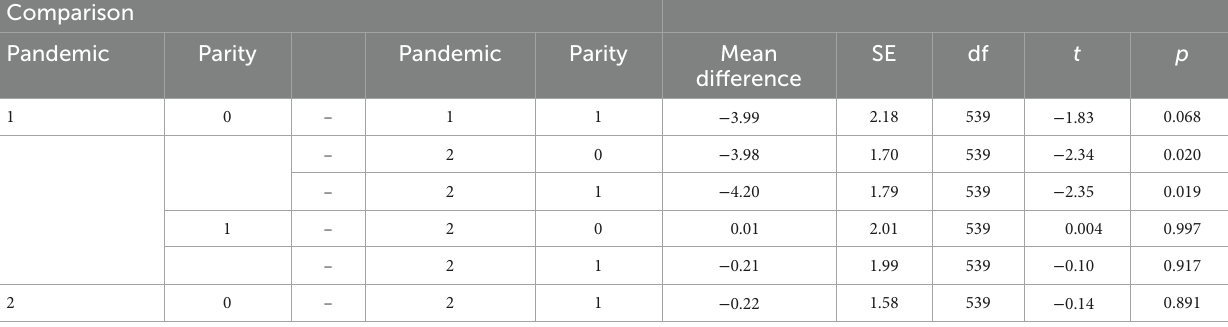
TABLE 5 Post hoc comparisons — The effect of the pandemic and parity on disgust sensitivity (overall DS-R score) in pregnant women.